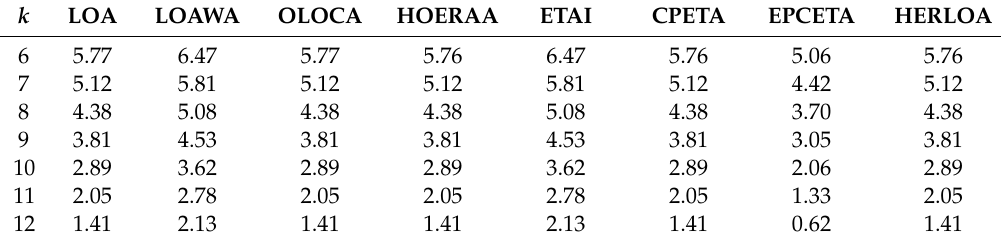
Table 2. Mean relative error distances (MREDs) of 16-bit approximate adders at various values of design parameter k